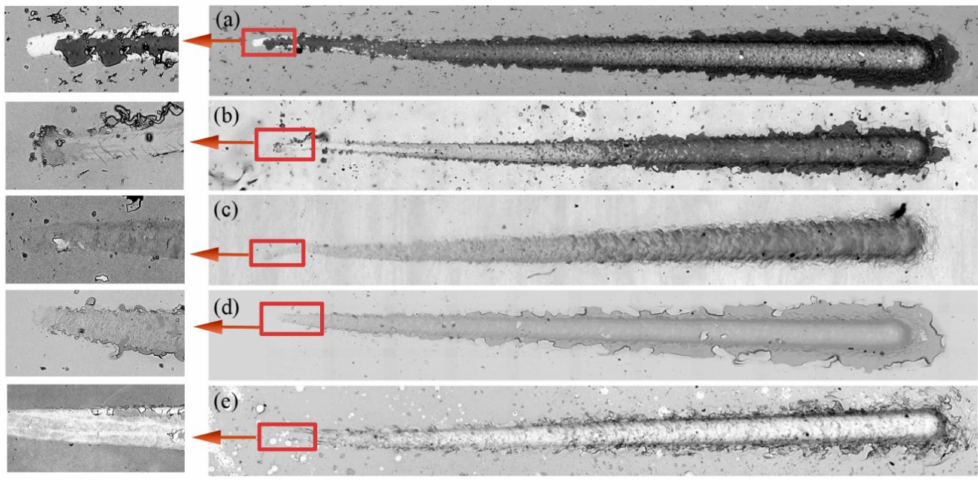
Figure 8. Scratches of ( a ) Cu10; ( b ) Cu20; ( c ) Cu5Al5; ( d ) Cu5Al5 (100 ◦ C); ( e ) Cu5Al5 (200 ◦ C) coatings annealed at 500 ◦